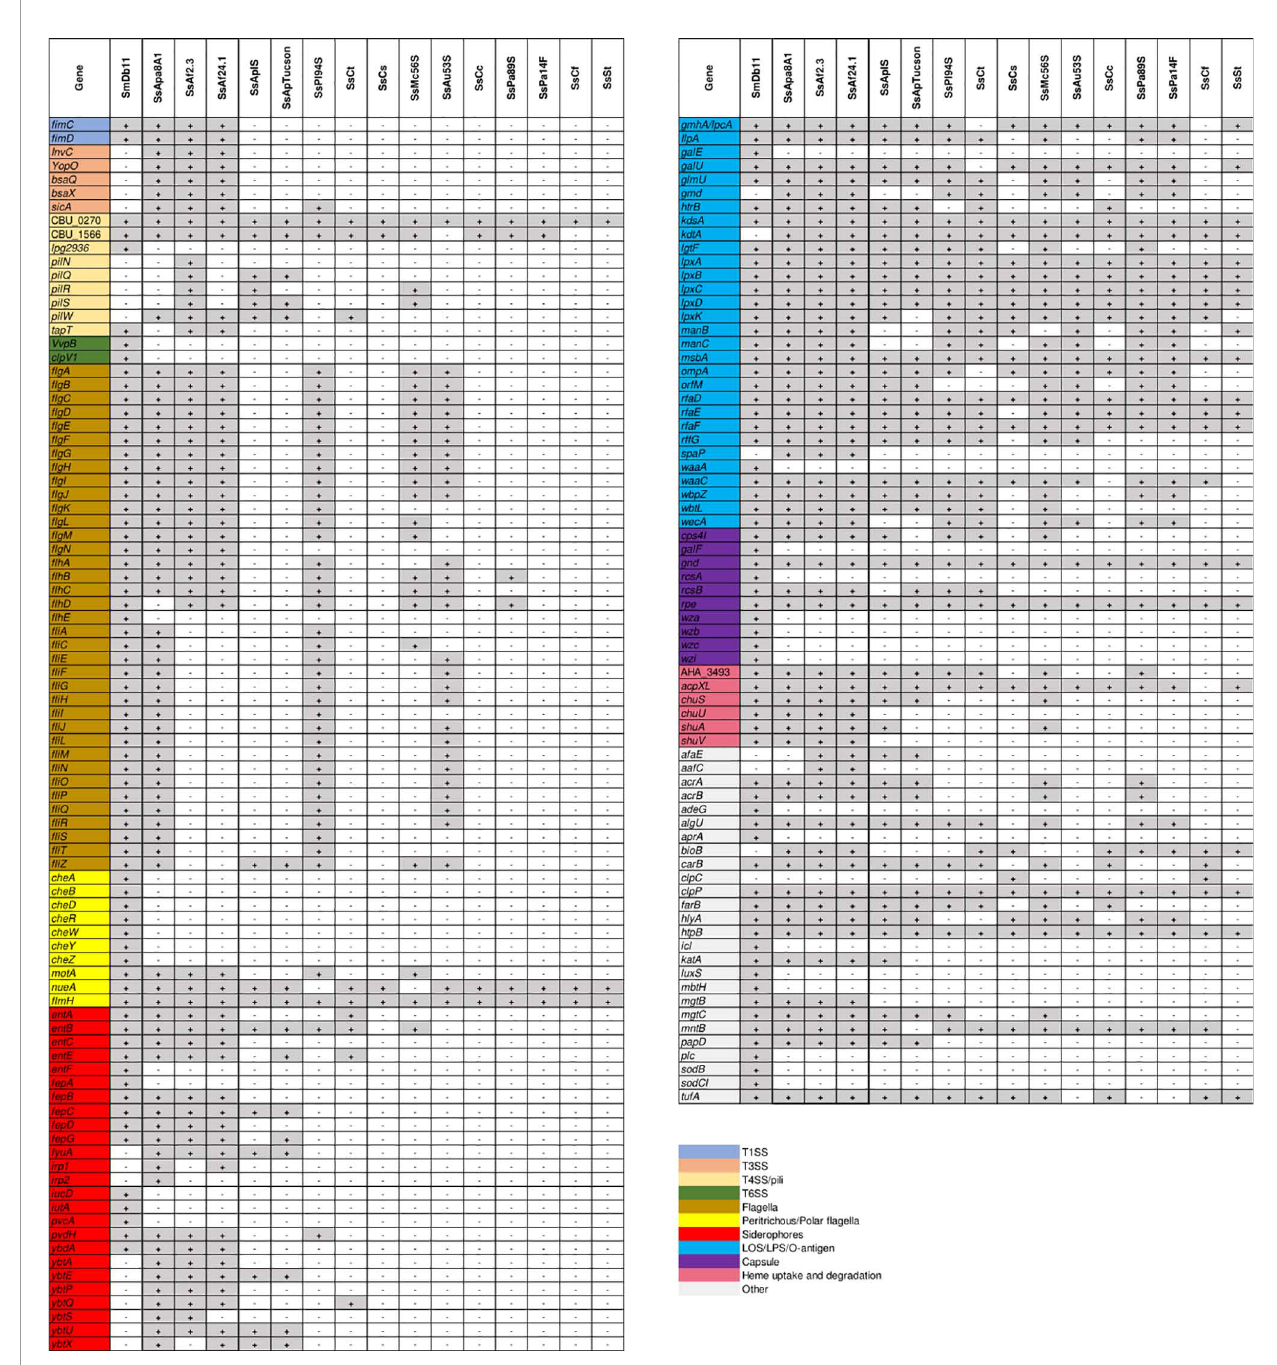
FIGURE 6 | Presence/absence map of S. symbiotica virulence genes. Presence of a virulence gene is labeled in gray and absence in